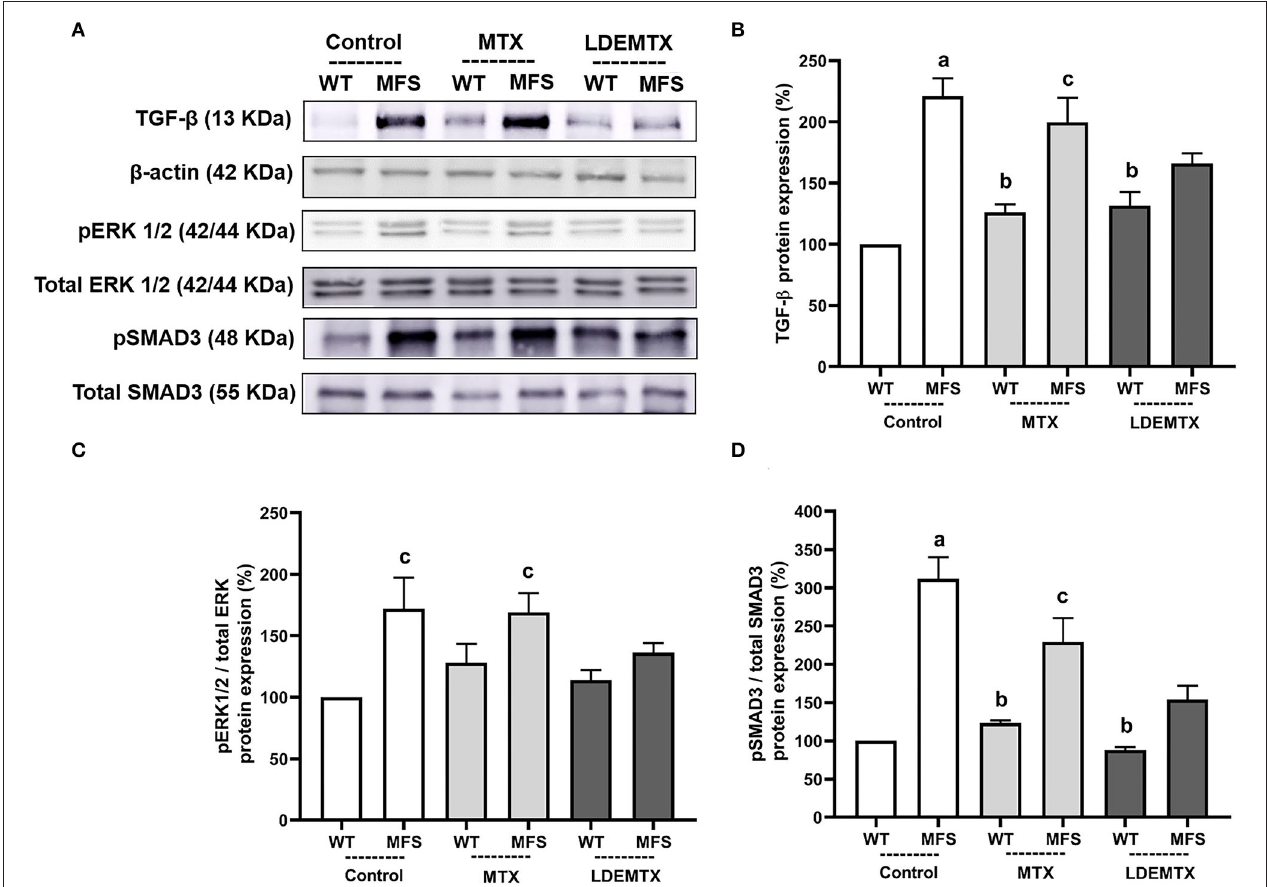
FIGURE 5 | Representative bands (A) and graphs showing western blot analysis of transforming growth factor (TGF)- β (B) , phosphorylated extracellular signal-regulated kinases ½ (pERK1/2)/total ERK1/2 (C) , and pSMAD3/total SMAD3 (D) protein expression in WT and MFS mice at 6 months of age, treated with MTX and LDEMTX. Values were normalized for the expression of β -actin, and results were expressed as a percentage of WT WT-control group means. Data are means ± SEM of a pool of aorta segments, comprising ascending aorta, aortic arch, and descending aorta ( n = 4, per group). (a) p < 0.01 vs. WT-control; (b) p < 0.01 vs. MFS-control; and (c) p < 0.05 vs.